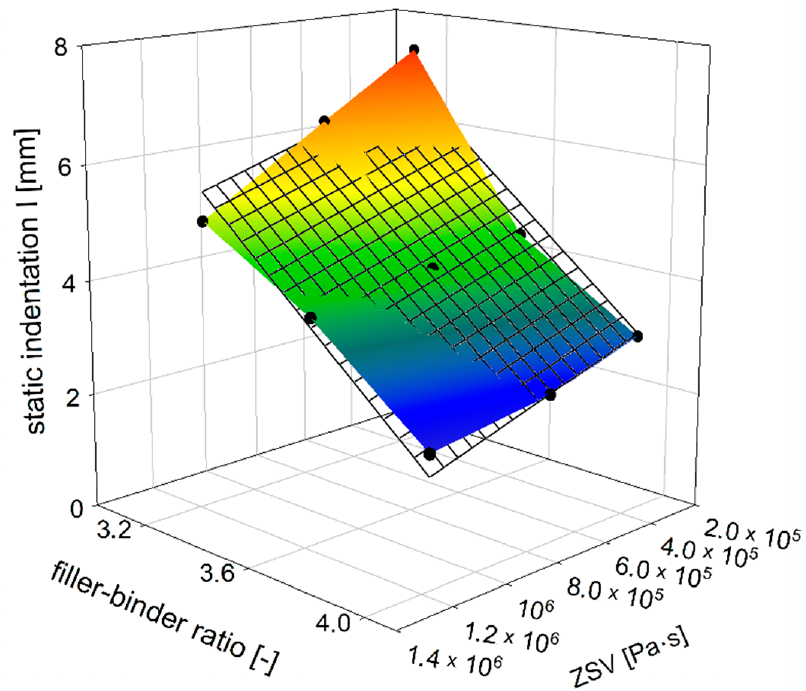
Figure 4. The dependence of MA static indentation on ZSV of TLA-modified binder and filler–binder ratio. The mastic composition has a big impact on the static indentation of the MA mixture. The permanent deformation resistance directly depends on the mastic’s stiffness, since the coarse aggregate grains are suspended in the mastic and have no direct contact with each other. Increasing the filler–binder from 3.2 to 4.0 results in a decrease in static indentation by about half (Figure 5). On the other hand, with a constant value of the filler–binder ratio, the binder change by the TLA content increase no longer causes such large changes in indentation values. The decrease in indentation value at the constant ZSV value of the binder, which represents the MA mixture modification without the change of the binder, is similar for each level of the TLA content, here represented by the relevant ZSV value. The increase in the ZSV value of TLA-modified binder, as an effect of the TLA addition, is most pronounced in a soft mixture, i.e., with a lower filler–binder ratio (Figure 6). In the case of a stiffer mixture—where the filler–binder ratio is 4.0—the static indentation decrease rate is much smaller. This difference in absolute terms is 2.42 and 0.84 mm for filler–binder ratios of 3.2 and 4.0, respectively. For percentages, this decrease rate is at a comparable level of 32 and 27%,